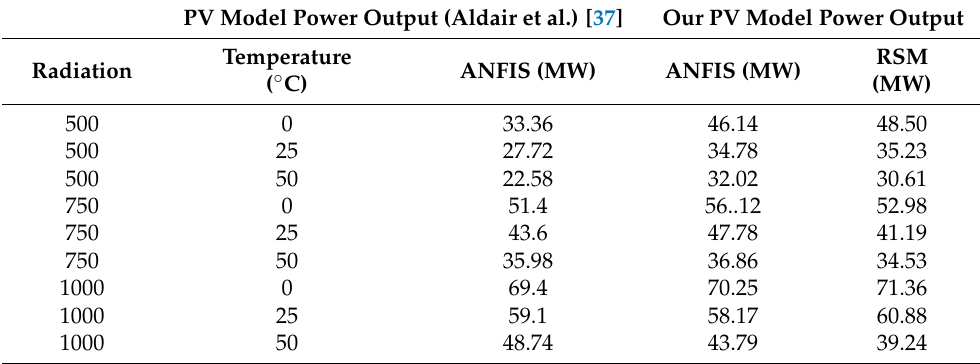
Table 3. The PV power output comparison of ANFIS and RSM